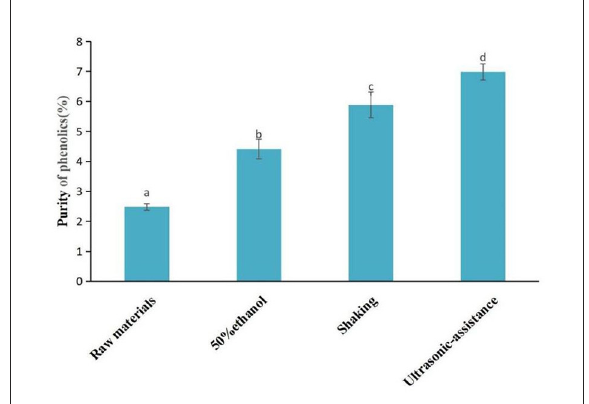
FIGURE10 Comparison of purity of phenolics in extracts using different extraction